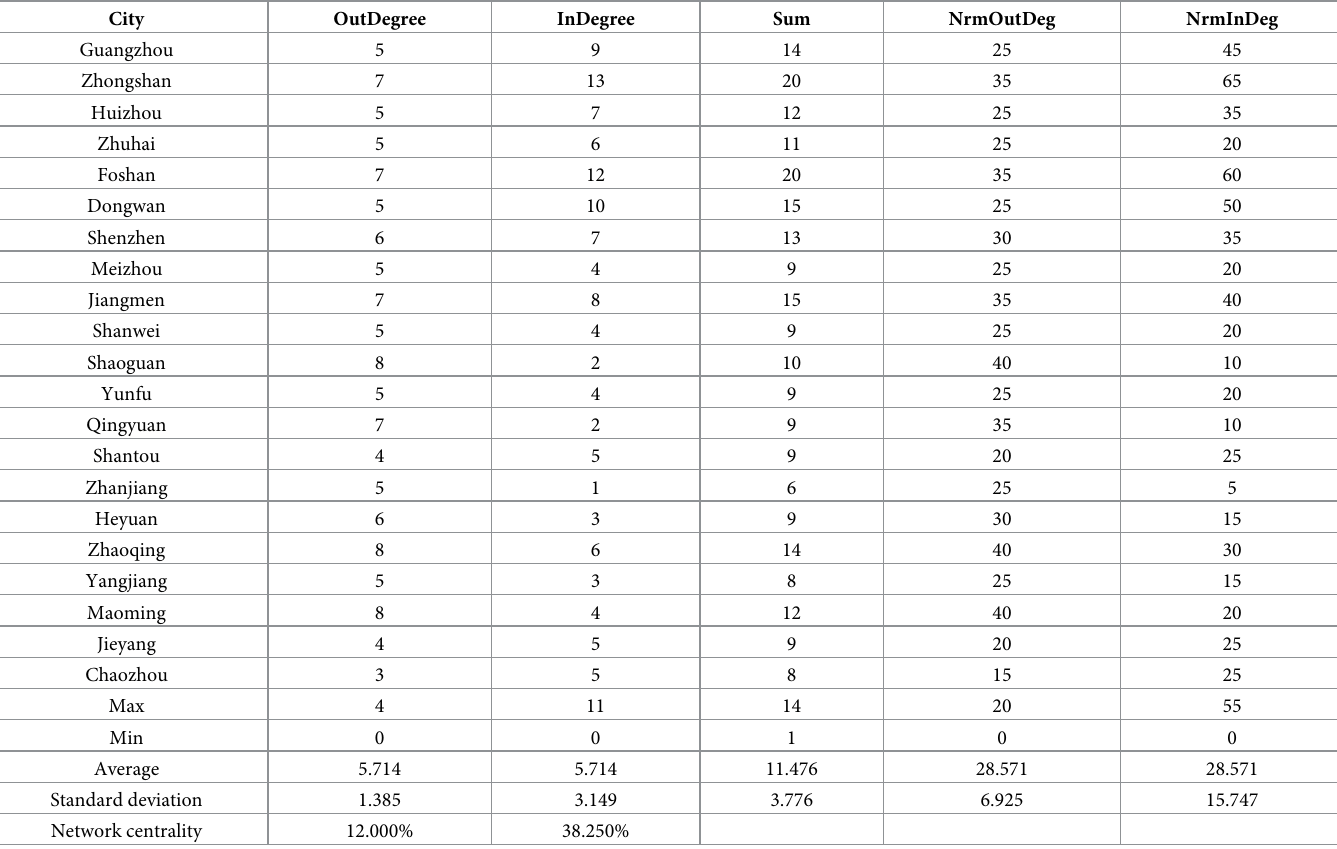
Table 7. Point centrality of the spatial correlation